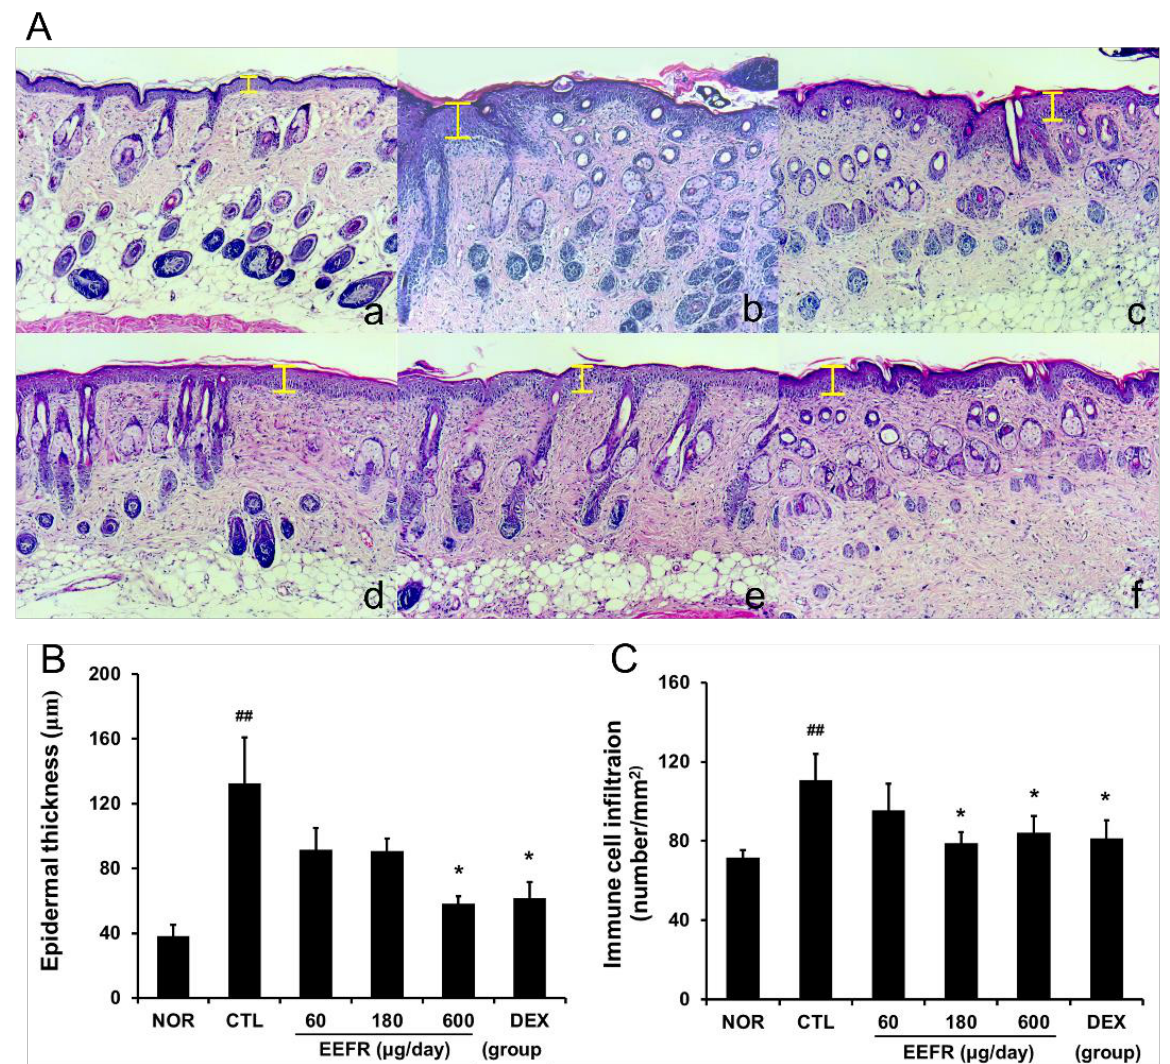
Figure 5. Effects of EEFR on histopathological abnormalities in inflamed tissues. The sequence is the same as in Figure 4A. The yellow bars indicate epidermal thicknesses (original magnification × 100) ( A ). Histogram showing mean epidermal thicknesses ( B ) and numbers of infiltrating immune cells ( C ) in the six study groups. Abbreviations are as defined in Figure 4. Results are presented as means ± SDs. ## p < 0.01 vs. NOR; * p < 0.05 vs. CTL.